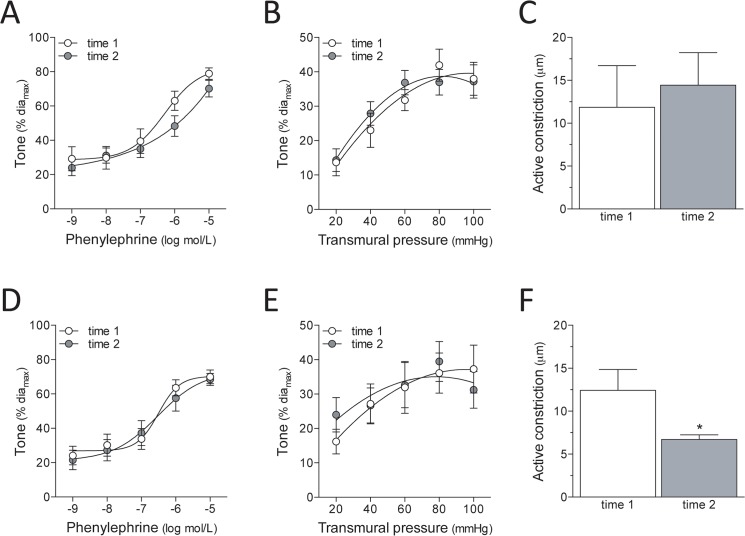
Response stability in human mesenteric and skeletal muscle resistance arteries.Time-control experiments confirm that (A) phenylephrine (PE)-stimulated vasoconstriction (logEC50 = -6.4±0.2; diamax = 173±33μm; n = 7 vessels from N = 5 patients), (B) myogenic tone (diamax = 185±34μm; n = 7, N = 4) and (C) active myogenic constriction (following a pressure step from 60mmHg to 100mmHg; diamax = 105±15μm; n = 7, N = 3) are consistent in human mesenteric resistance arteries over two separate assessments. (D) PE-stimulated vasoconstriction (logEC50 = -6.5±0.1; diamax = 104±13μm; n = 10, N = 10) and (E) myogenic tone (diamax = 122±21μm; n = 9, N = 8) are also consistent over two separate assessments in human skeletal muscle resistance arteries; however, (F) active myogenic constriction (diamax = 94±9μm; n = 7, N = 6) is not stable. Diamax is defined as the maximal diameter (under calcium free buffer conditions) at 60mmHg. Myogenic tone (Panels A and D) and PE responses (Panels B and E) were statistically compared with a paired two-way ANOVA; active constriction measures (Panels C and F) were compared with a Wilcoxon test. * denotes P<0.05 for a paired comparisons.